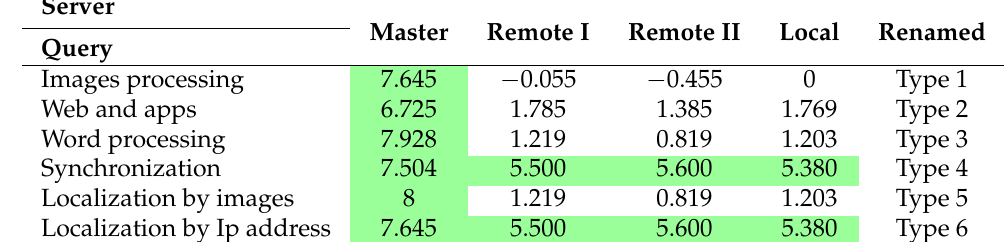
Table 13. Assignment query process based on saaq score .